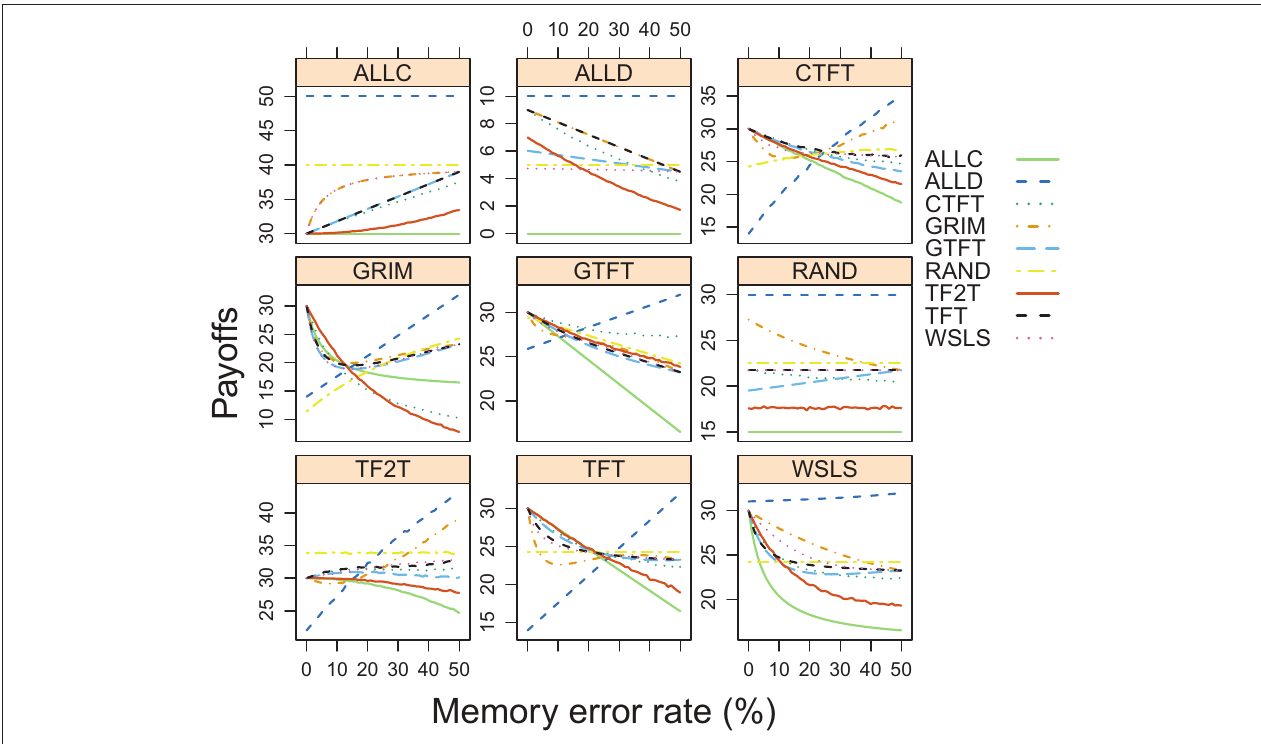
FIguRE 6 | game-theoretical payoffs of strategies as a function of error rate. For each strategy, we calculated how all strategies perform against that strategy over a range of error rates. When the strategy playing against itself has a higher payoff than any other strategy playing against it, this is an evolutionarily stable strategy (ESS). Strategies CTFT and TF2T were simulated rather than analytically